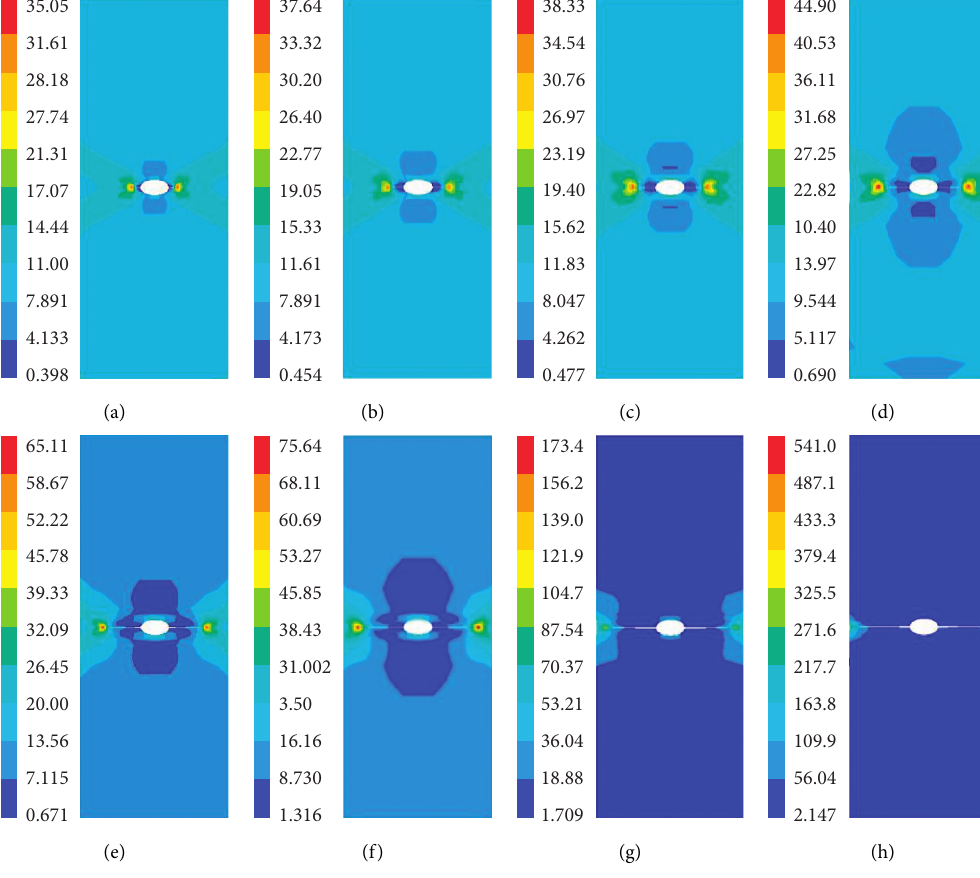
Figure 6: Mises stress distributions of the plate with different crack lengths: (a) 0.5mm, (b) 1.0mm, (c) 1.5mm, (d) 2.0mm, (e) 2.5mm, (f) 3.0 mm, (g) 3.5mm, and (h) 4.0